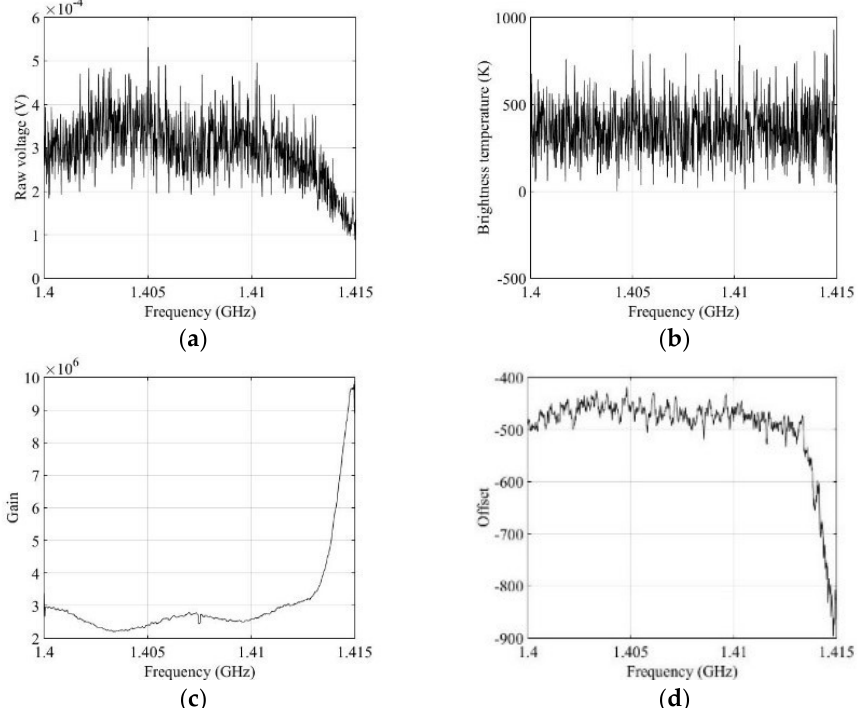
Figure 5. Radiometer calibration: ( a ) raw voltage data over a 0.1-s data; ( b ) brightness temperatures after radiometer calibration; ( c ) gain values; ( d ) offset values.